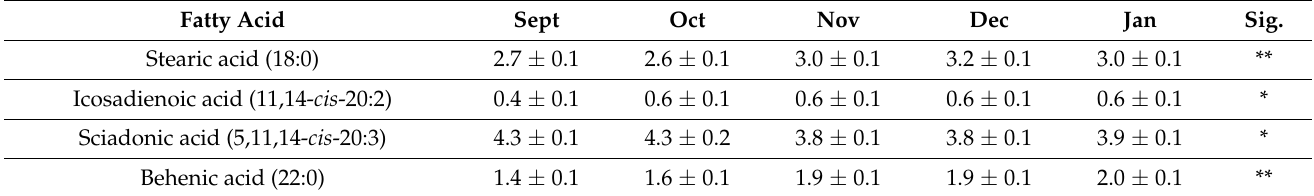
Table 2. Fatty acid relative percentages in balsam fir needles from low and high needle abscission resistance genotypes of balsam fir collected initially in September to establish a baseline fatty acid profile at the beginning of the experiment. Data is presented as mean ± standard error as calculated from 20 branches. An * indicates 1–5% significance while ** indicates less than 1% significance due to sampling